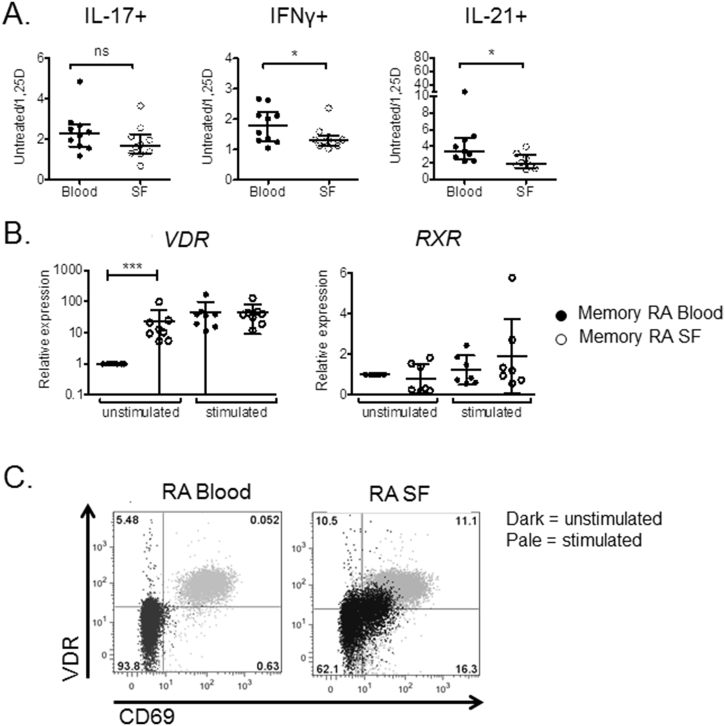
Memory T cells from synovial fluid are relatively insensitive to 1,25(OH)2D3compared to memory T cells from peripheral blood. CD45-RO + memory T cells were isolated from synovial fluid (SF) and peripheral blood of established RA patients and stimulated with anti-CD3/CD28 beads in the presence or absence of 1,25(OH)2D3 (+1,25D) overnight or for 5 days. Response to 1,25(OH)2D3 was assessed by measurement of IL-17, IFNγ and IL-21 by flow cytometry at 5 days and relative expression of cytokines in the presence vs the absence of 1,25(OH)2D3 calculated for n > 9 donors (A). Significant differences were tested using Wilcoxon matched pairs tests. ns = non-significant, * = P < 0.05. (B) Effects of cell location and 20hr stimulation on VDR and RXR mRNA transcripts were examined by qPCR (B). Expression is given relative to the level in unstimulated memory cells. Statistical significance was tested by repeated measures two-way ANOVA. * = P < 0.05, *** = P < 0.001, ns = not significant. VDR expression in CD4+ T cells from blood and synovial fluid was also assessed by flow cytometry for n = 3 donors. Representative data for CD69 versus VDR are shown in (C).